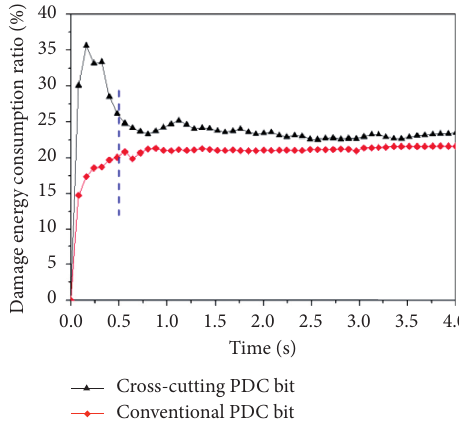
Figure 15: Damage energy consumption ratio in rock